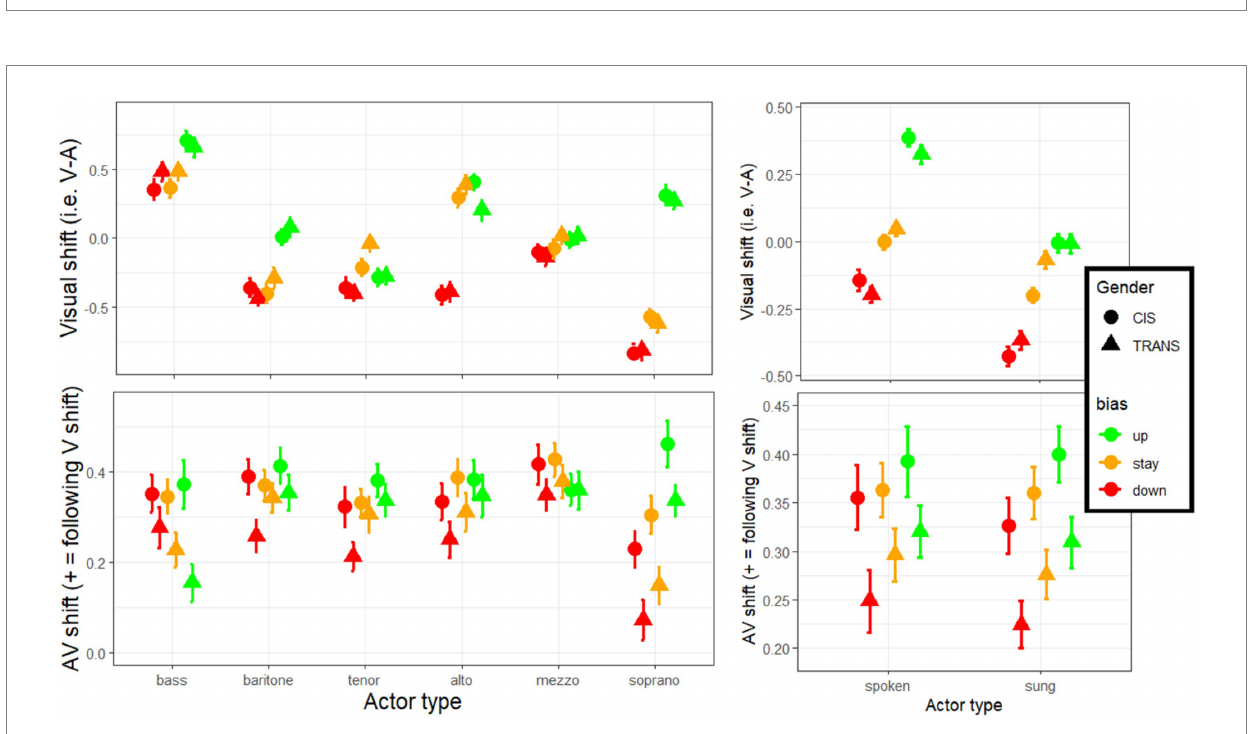
FIGURE 7 Size of the V shift and AV shift, split by the actor’s match or mismatch between their appearance and their